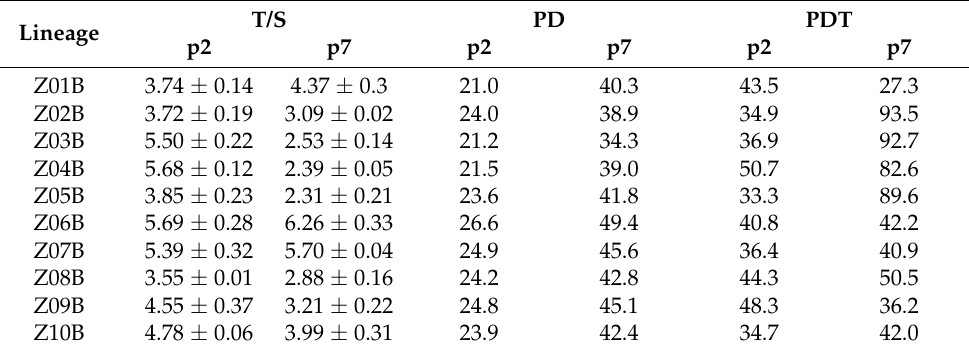
Table 2. Telomere repeat copy number to single-gene copy number (T/S) ratio and standard devia- tions, cumulative population doubling (PD), and population doubling time (PDT) values from all ten lineages of DPSCs. Standard deviations of the T/S ratio were calculated for three technical replicates without biological replicates.